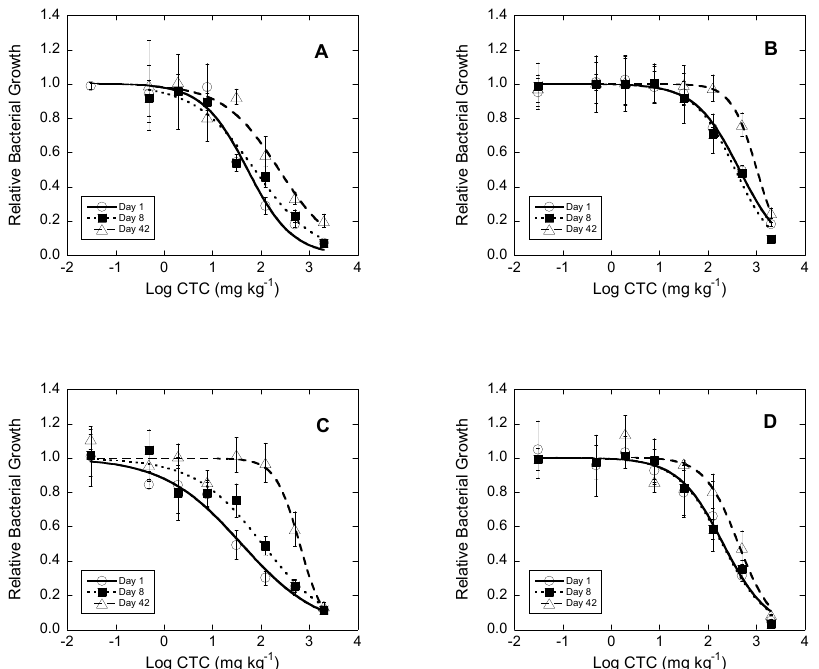
Figure 2. Relative bacterial community growth in response to chlortetracycline (CTC) addition to the soil after 1, 8 and 42 incubation days in 4 soil samples (used as example). A , B , C and D represent soil samples 3, 10, 11 and 20 (Table S1, Supplementary material).